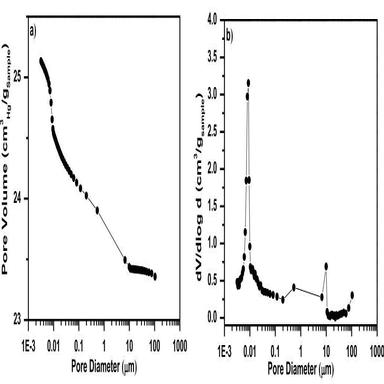
(a) Overall mercury pore volume and (b) corresponding distribution assessed by low- and high-pressure sweeps for EC-RF.